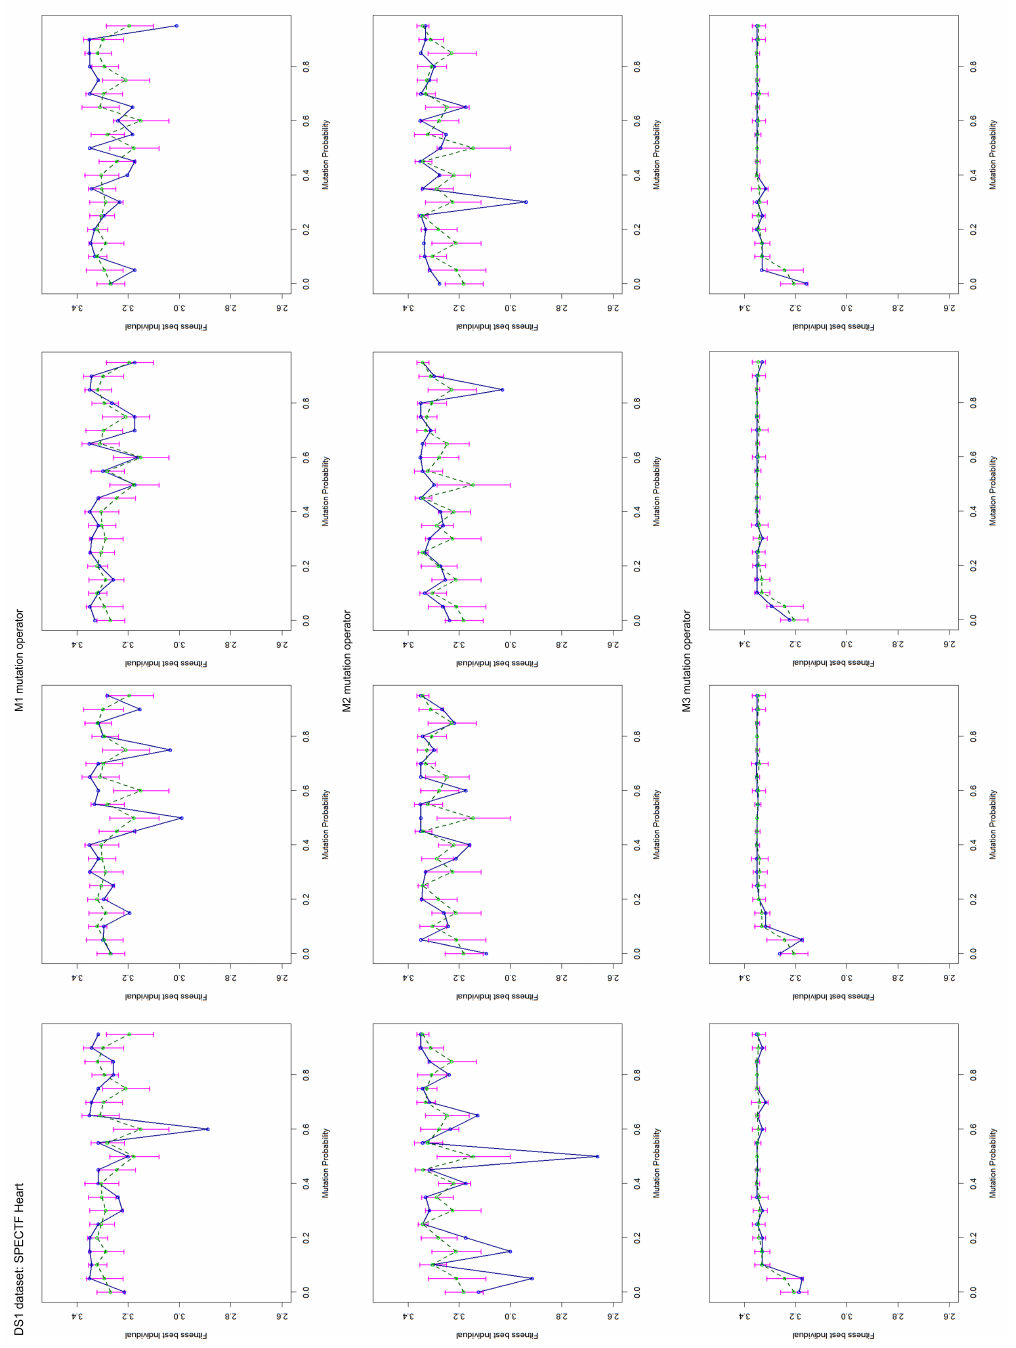
Figure A1. Mutation tests for mutation operators M1, M2, and M3 for the DS1 dataset. Each row (with four graphics) in the figure corresponds to the same mutation operator and each graphic corresponds to 20 executions of the evolutionary method for 20 mutation probability values with step 0.05. The blue curve represents fitness values against mutation values. The green curve represents the mean fitness values from the four graphics in the same row and the pink lines state the standard error